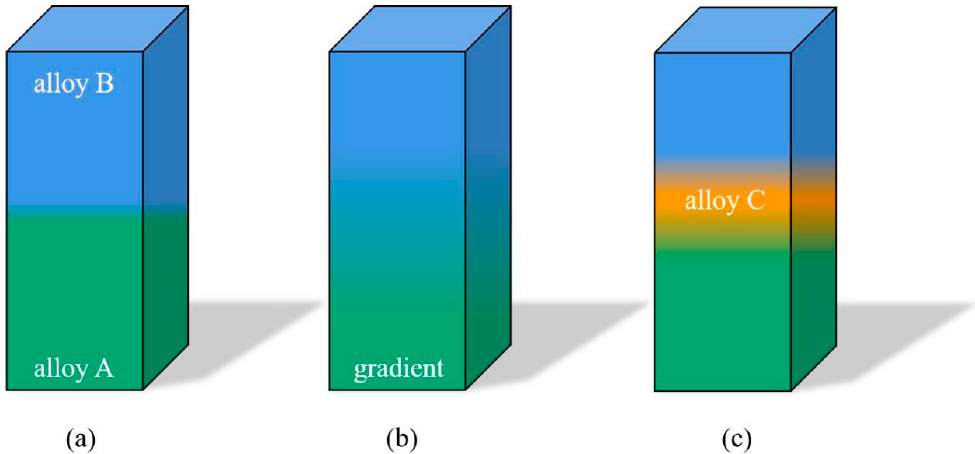
Figure 1. Schematic of dissimilar metal materials structure—different colours represent various metals or alloys, ( a ) represents a sharp transition; ( b ) represnets a gradient variation; ( c ) represents an intermediate layer added.